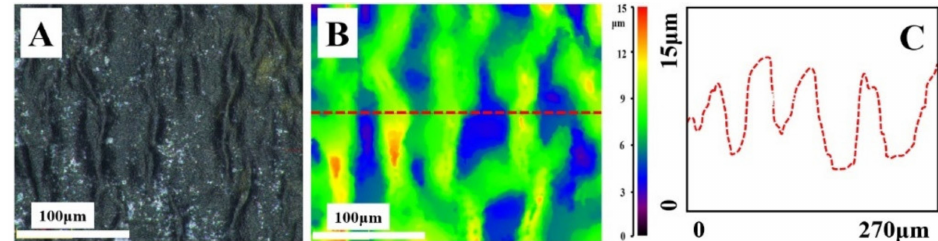
Figure 5. Digital microscope images of CNTs@PLLA composite membranes with wrinkle ( A ), the 3-D morphology ( B ), and corresponding line-cut profile at the indicated position in ( C